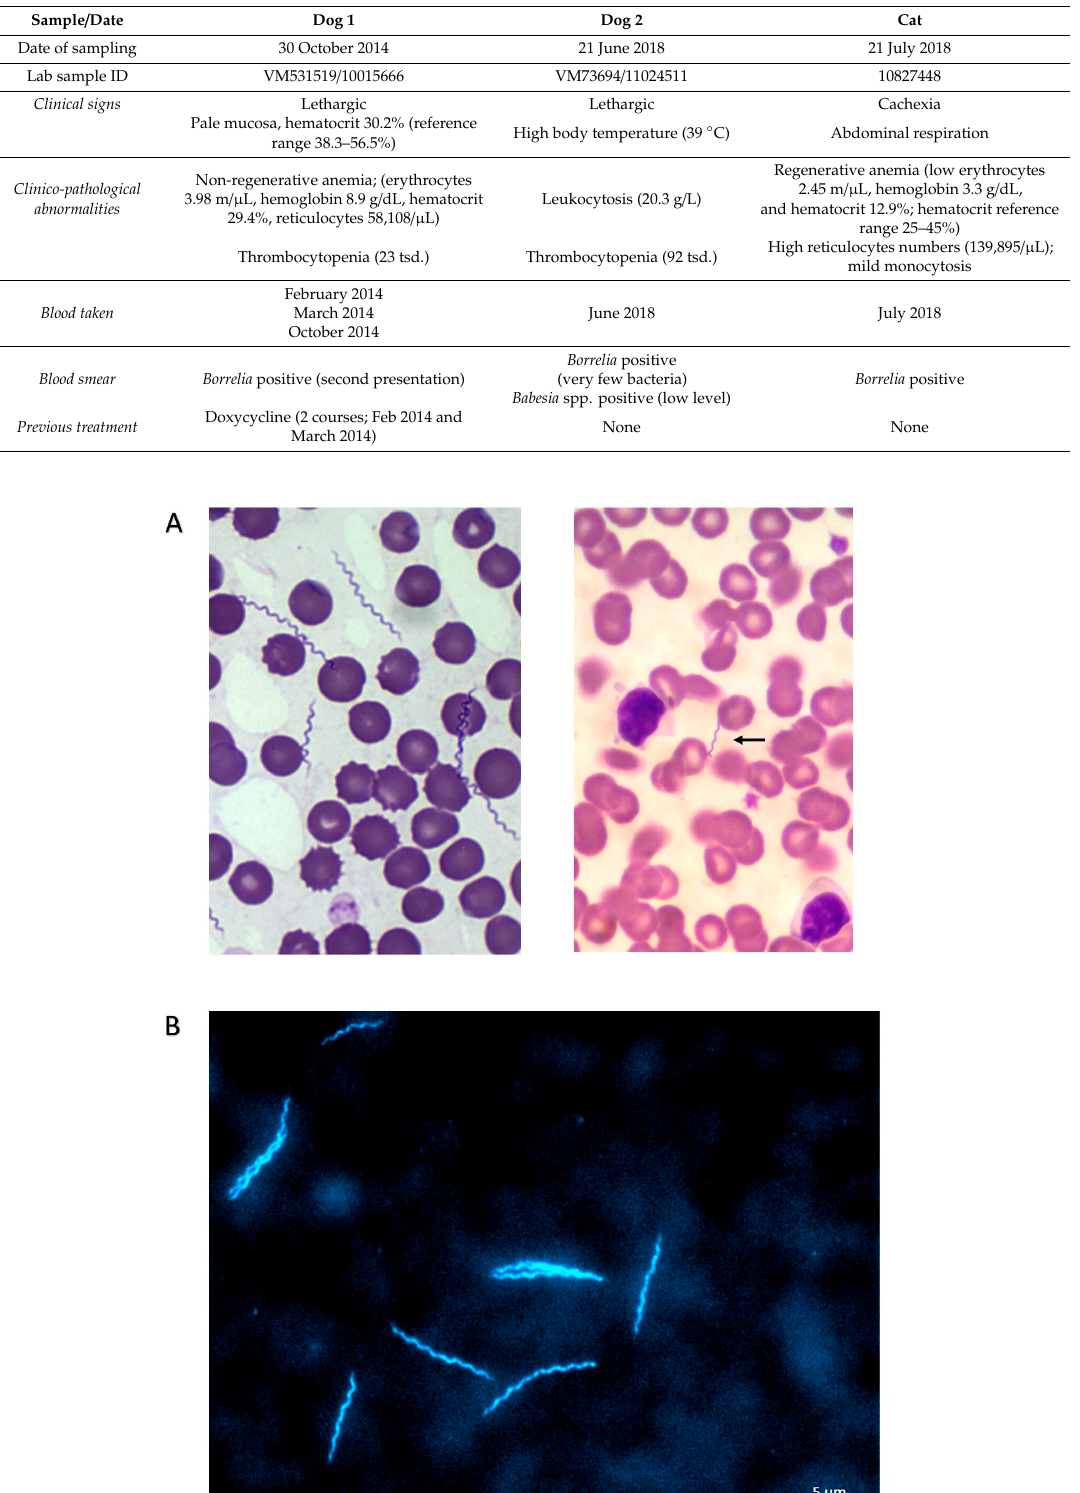
Table 1. Clinical signs and clinicopathological abnormalities in Borrelia hispanica infected animals.